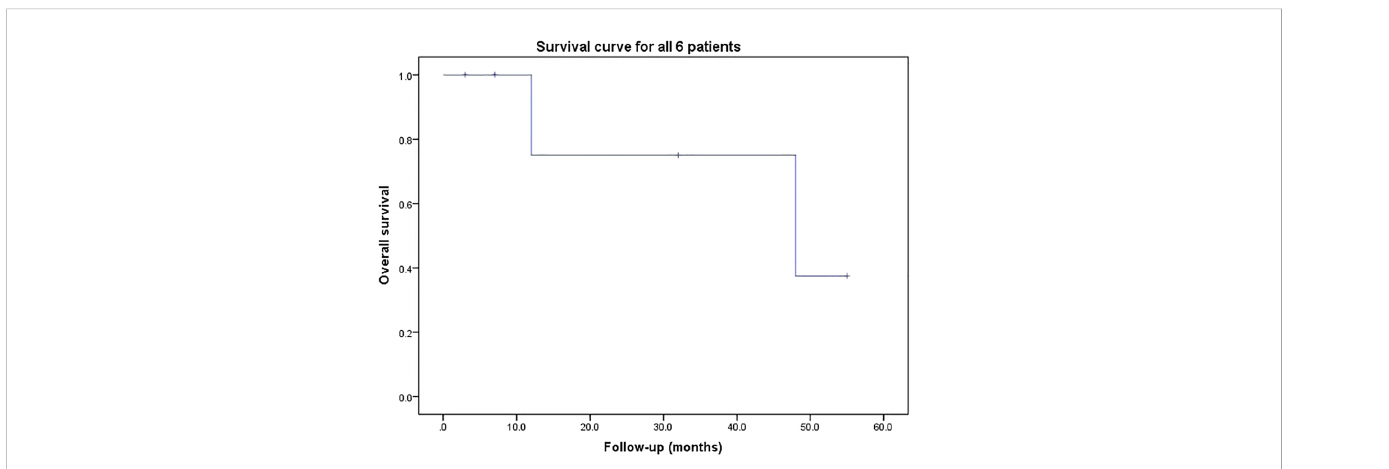
FIGURE 2 Survival curve for all 6 patients. The median survival of the six patients was 48